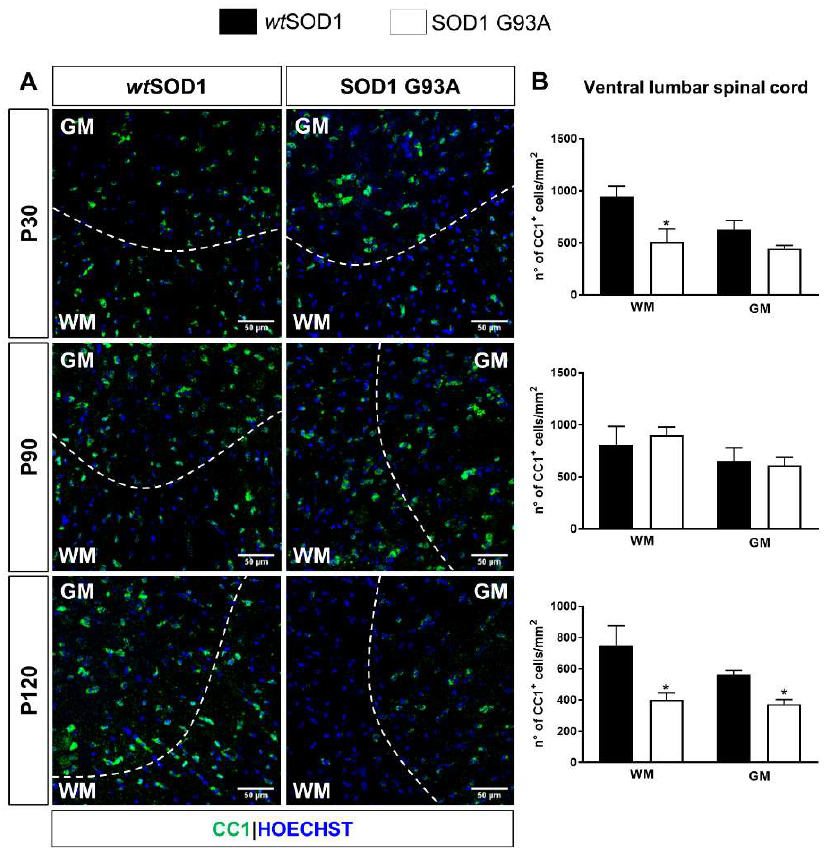
Figure 2. Alterations of mature oligodendroglial cells in lumbar spinal cord of SOD1 G93A mice. ( A ) Representative images of CC1 staining in the ventral lumbar spinal cord of wt SOD1 and SOD1 G93A mice at pre-symptomatic stage P30, early symptomatic stage P90 and late symptomatic stage P120. Hoechst 33258 was used to label cell nuclei. Dashed line separates white matter (WM) and grey matter (GM). Scale bar: 50 µ m. ( B ) Histograms show the quantitative analysis of the density of CC1 + cells in WM and in GM of the ventral lumbar spinal cord ( n = 3). * p < 0.05, SOD1 G93A vs wt SOD1; Student’s t - test.